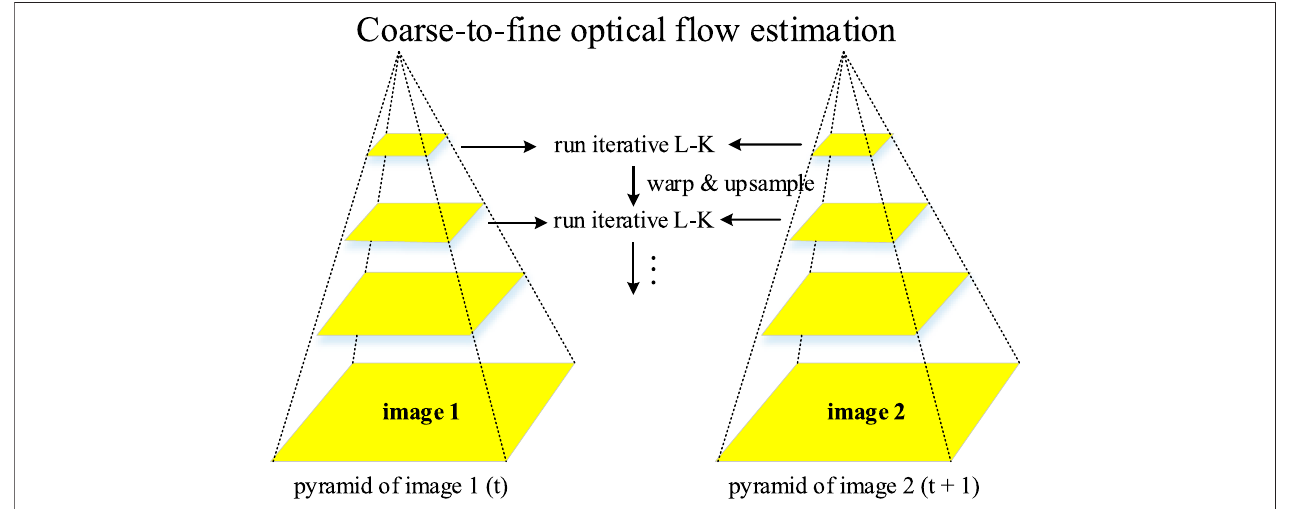
FIGURE4| Lucas Kanade method: estimate theoptical fl owofblackpixels.The pyramid method startsfromthe highestlevel ofthepyramid (with theleast details) to the lowest level of the pyramid (with rich